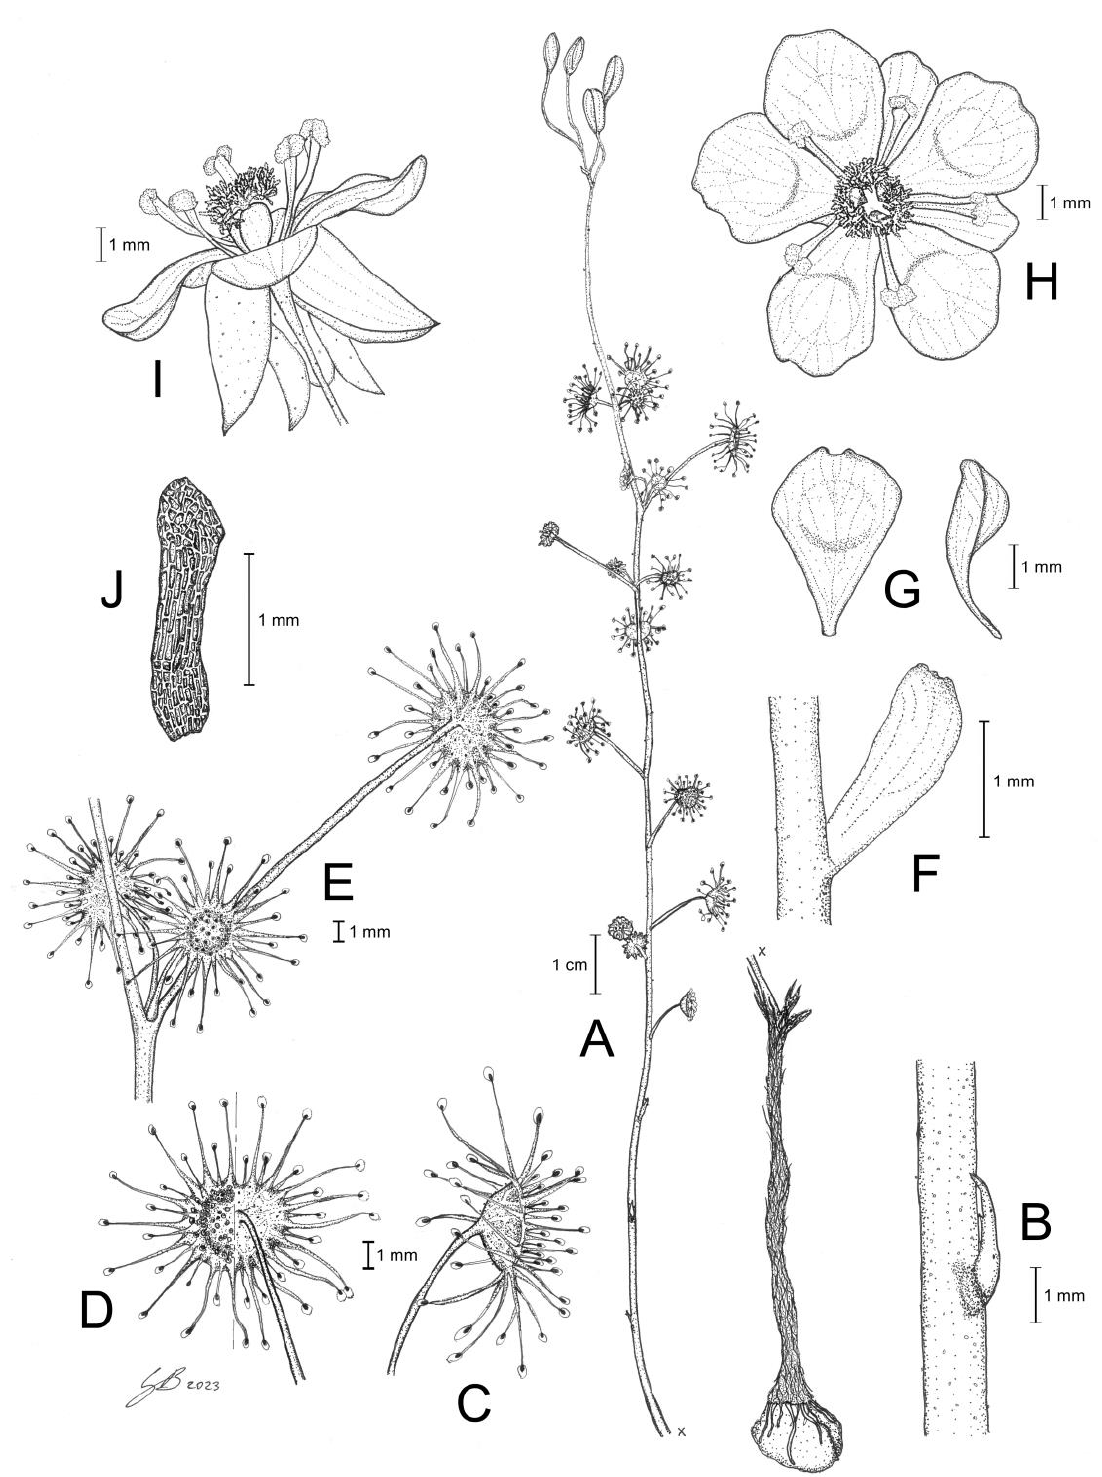
Figure 8. Drosera hortiorum T.Krueger & G.Bourke. ( A ) habit; ( B ) stem base with cataphyll; ( C ) lamina, lateral view; ( D ) lamina, left half adaxial view, right half abaxial view; ( E ) group of leaves from upper node of the stem, consisting of one cauline leaf and two axillary leaves; ( F ) bract; ( G ) petals, left adaxial view, right lateral view; ( H ) flower, top view; ( I ) flower, side view; and ( J ) seed. ( A – I ) from photographs of living plants from the type location, Wandoo National Park, Western Australia; ( J ) from near York, Western Australia. Drawing: G. Bourke.